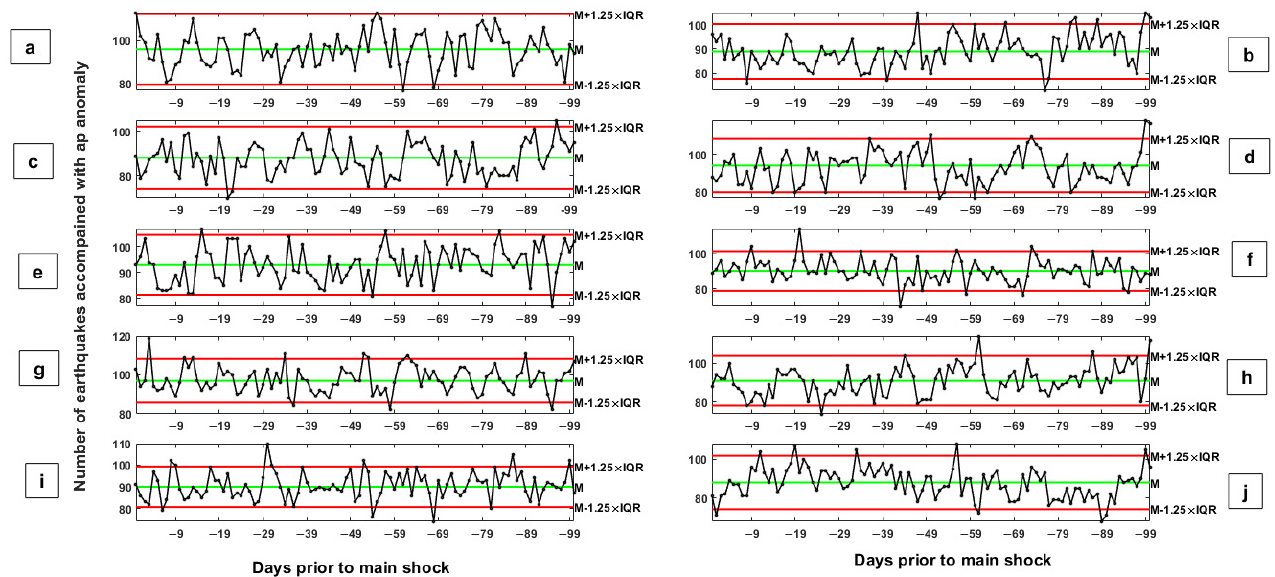
Figure 8. Panels ( a – j ) show results of 10 simulated earthquakes dataset. The y -axis in each panel indicates the number of simulated earthquakes accompanied by anomalous changes in the a p index during the days prior to the simulated earthquakes. Median and higher and lower bounds are drawn as green and red horizontal lines, respectively. The allowed ranges are defined as M ± 1.25 × IQR , in which M and IQR are the median and the inter-quartile range parameters, respectively.